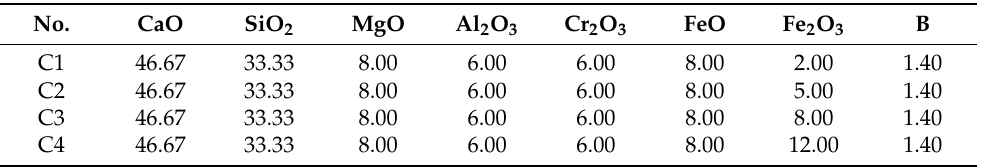
Table 1. Compositions of synthetic slag sample/g.